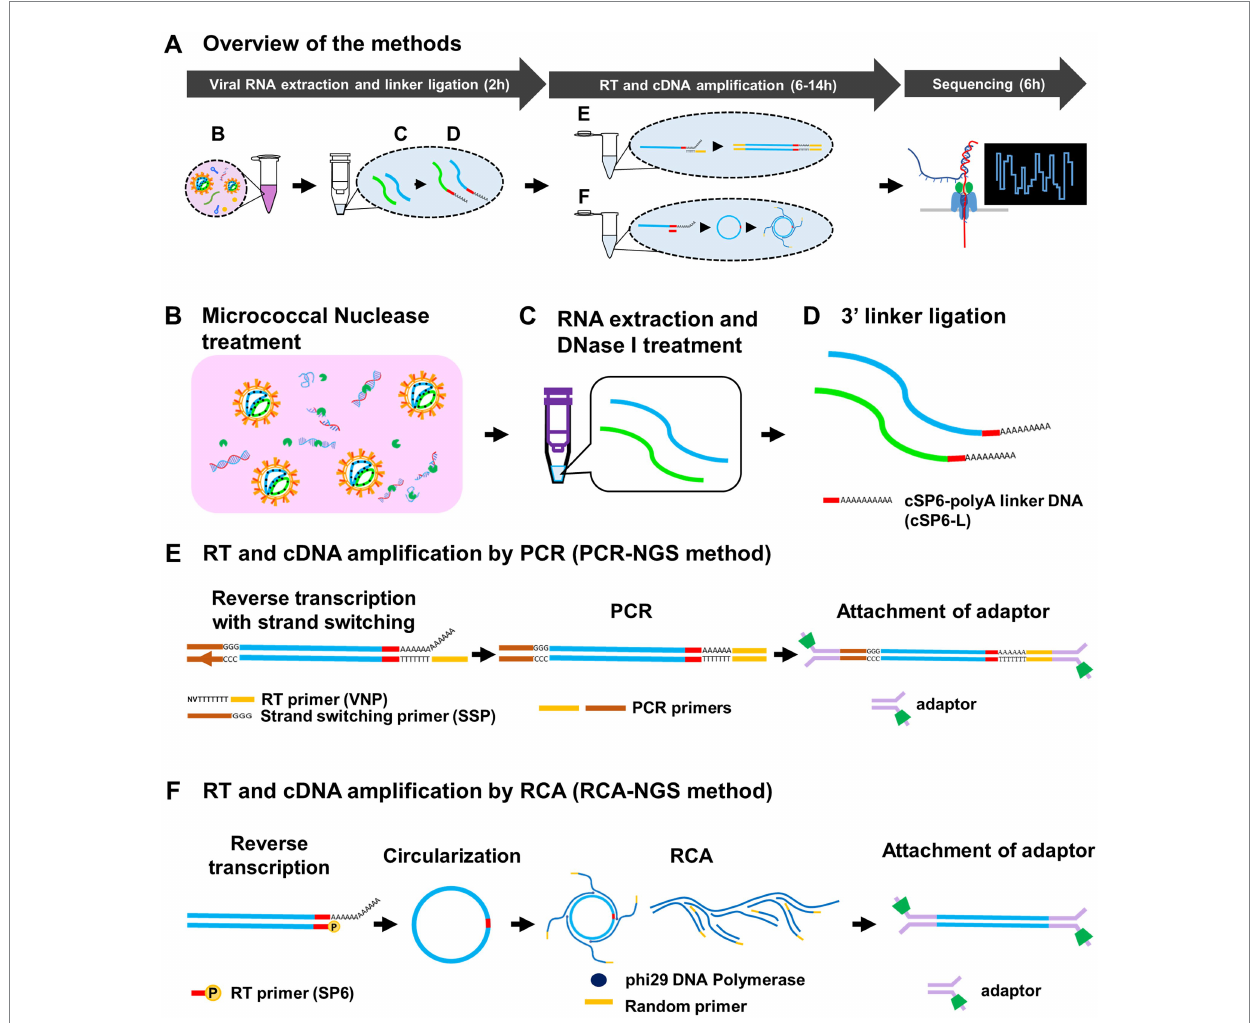
FIGURE 1 Schematic diagram of the methods for determination of entire RNA viral genome. Overview of the methods and approximate working hours (A) can be divided roughly into viral RNA extraction and linker ligation, RT and cDNA amplification by PCR or RCA, and Sequencing. The Micrococcal Nuclease, which is derived from Staphylococcus aureus and is a non-specific endo-exonuclease, treatment (B) to digest both DNA and RNA except viral RNA, DNase I treatment (C) to digest remaining DNA and 3 ′ barcoded polyA linker DNA (cSP6-L) ligation (D) were performed at the virus RNA extraction and linker ligation step. At the RT and cDNA amplification step, RNA in the sample is reverse transcribed using poly(T)-containing anchored RT primer (VNP) with strand-switching to add a unique sequence of SSP at the 5 ′ end and amplified by PCR (E) . Otherwise, the RNA is reverse transcribed using 5 ′ -phosphorylated SP6 primer (SP6), circularized using CircLigase II, and amplified by RCA using phi29 DNA polymerase with random primers (F) . These amplified cDNAs are then attached to the adaptors for sequencing. Note that the SP6 sequence serves as the barcode to identify the true end of viral terminal